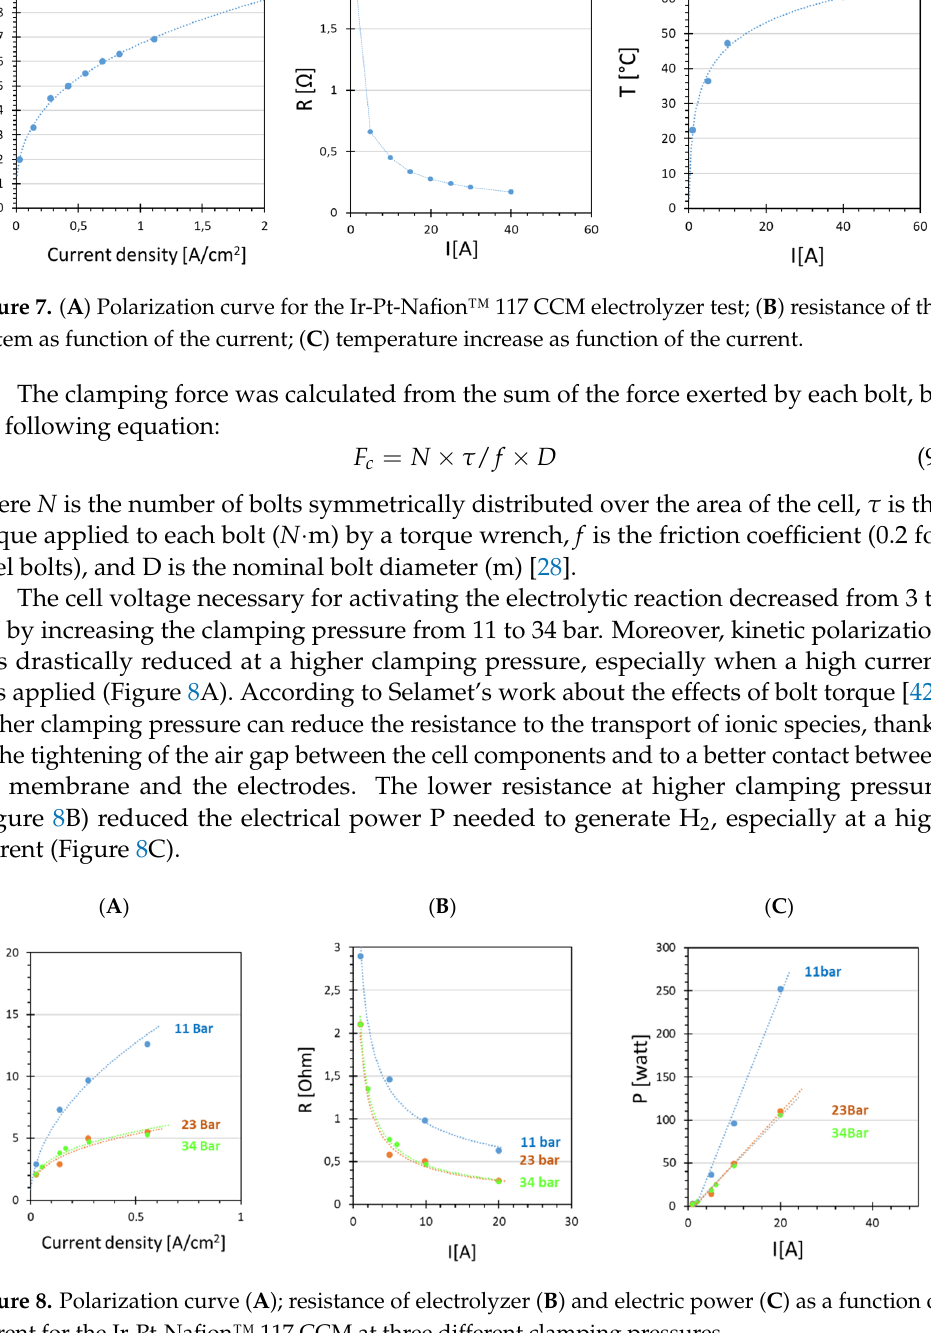
electrical power consumed. The high Faradaic efficiency in all experiments confirmed that H 2 crossover was negligible.